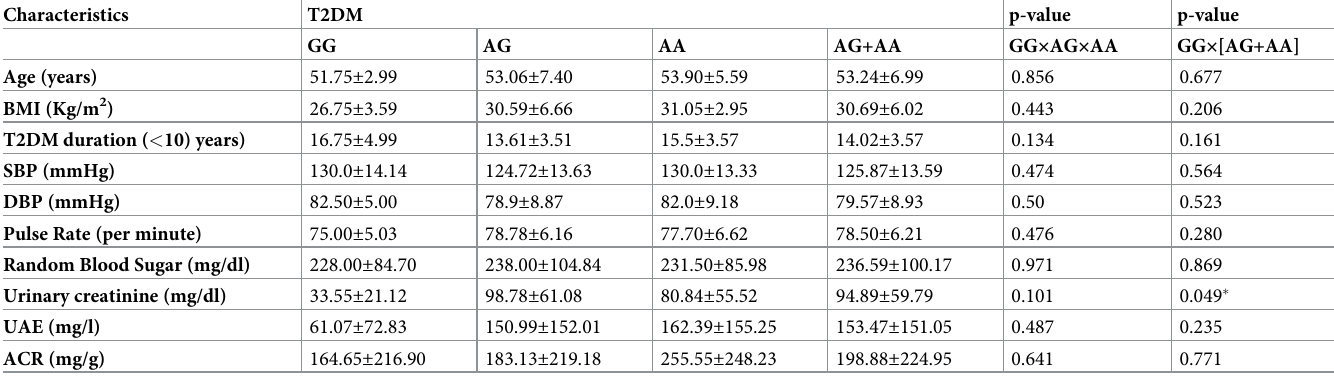
Table 4. Analysis of the influence of ACE2 G8790A polymorphism on clinical-biochemical variables in female T2DM patients. Characteristics